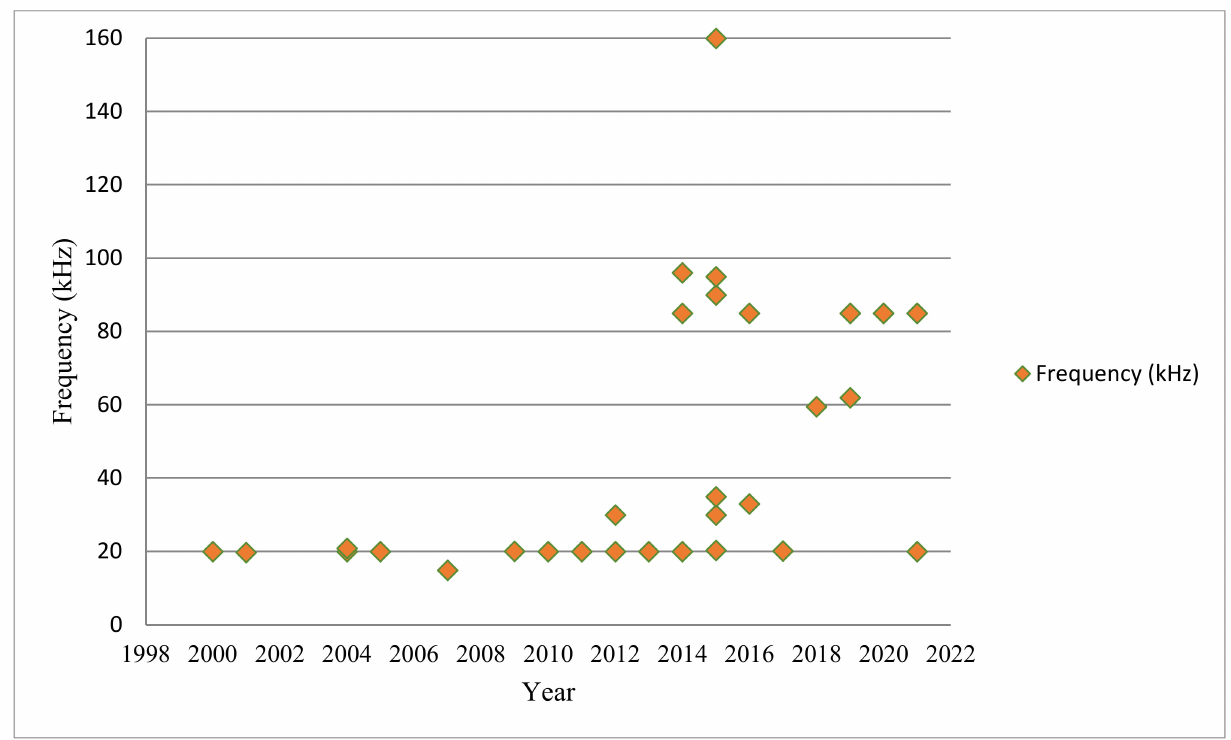
Figure 9. Frequency values used in academic studies by years of publication.